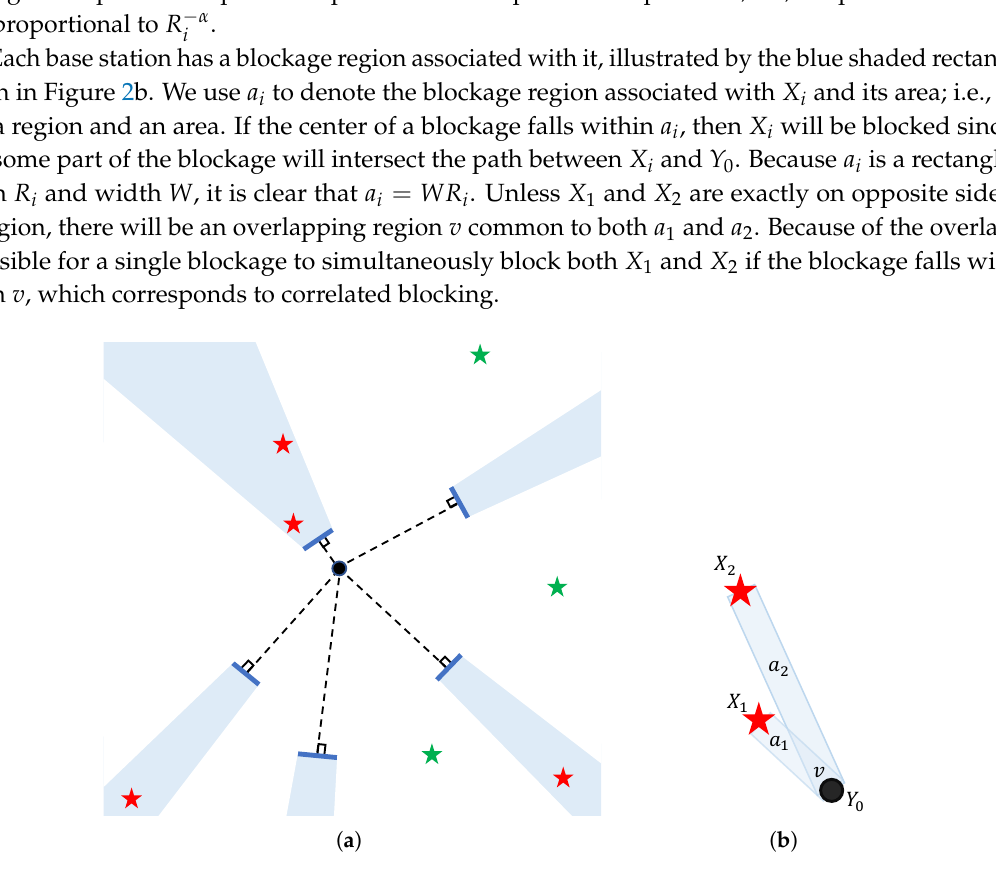
Figure 2. Illustration of the blockage model. ( a ) Network example consisting of base stations indicated by the stars and blockages indicated by blue lines surrounding the transmitter, which is indicated by the black circle. The blockages are modeled as a line of length W facing the transmitter; ( b ) Equivalent blockage regions. a 1 and a 2 are the blockage areas, and v is the overlapping